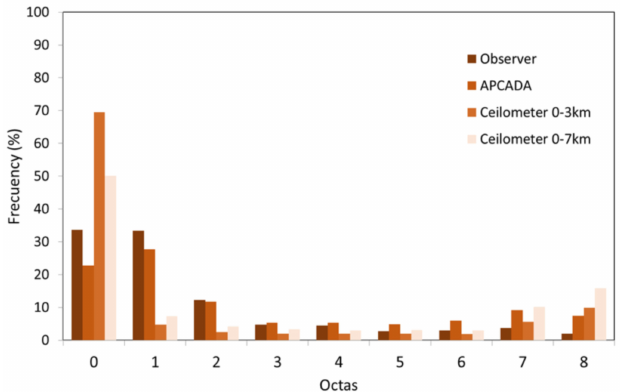
Figure 1. Frequency of cloud amount at low-medium levels as registered by meteorological observers, APCADA and ceilometer methods.